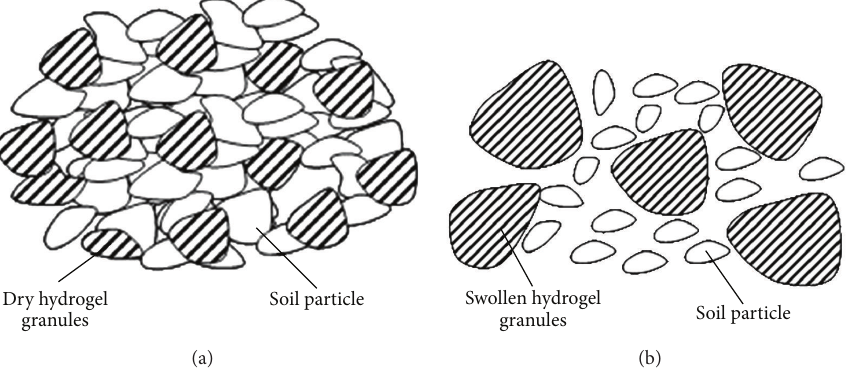
Figure 1: Effect of hydrogel swelling on soil porosity: (a) dry hydrogel, (b) swollen hydrogel. Adapted from